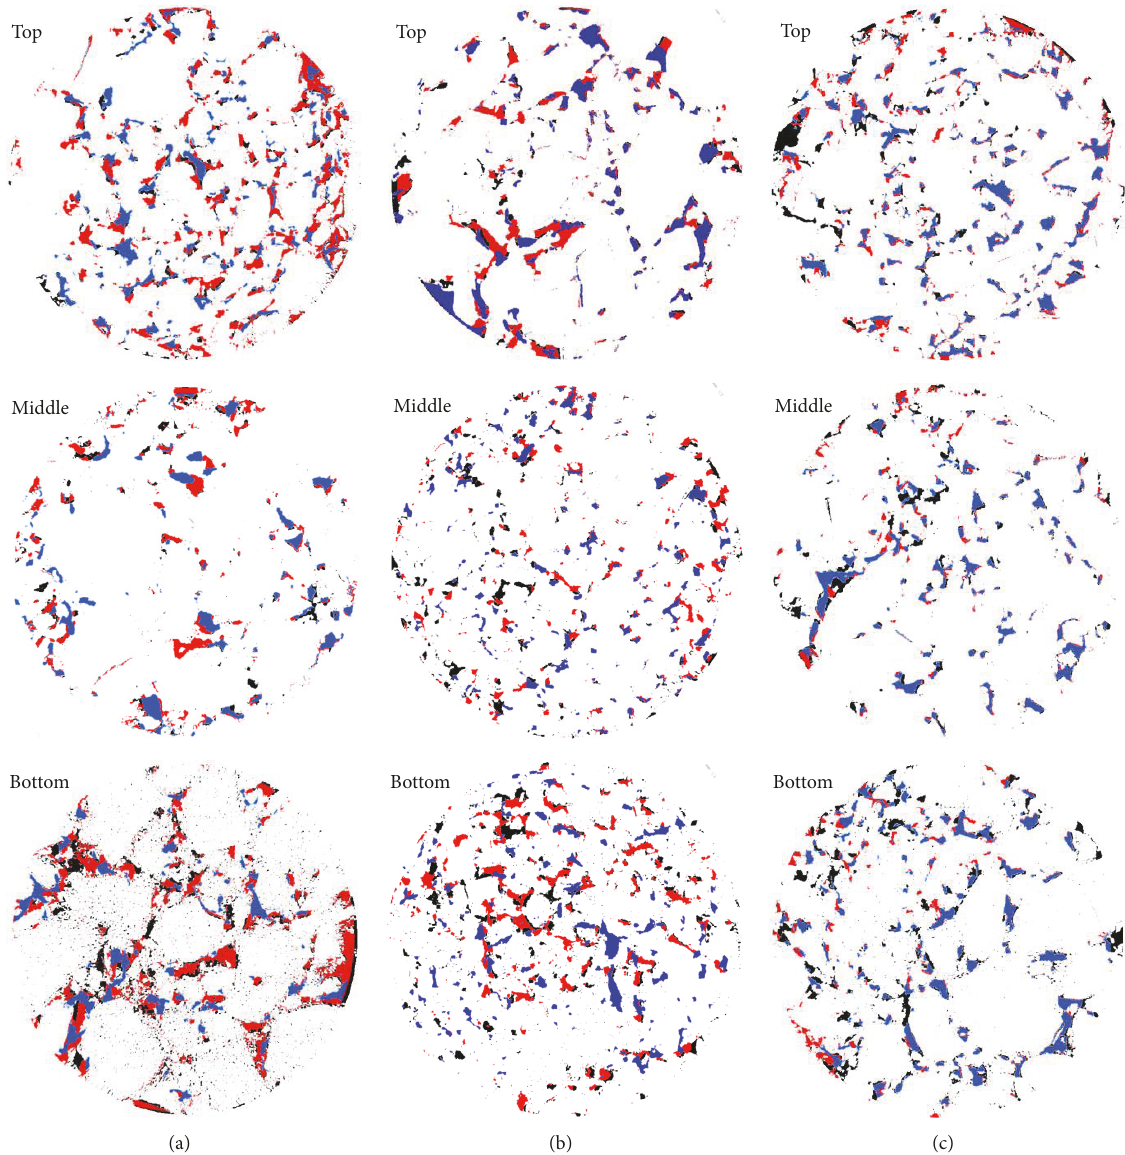
Figure 15: Change of the internal structures of the SRBM samples along the horizontal direction when the curing time was 28 d: (a) cement content = 4.0%; (b) cement content = 4.5%; (c) cement content =